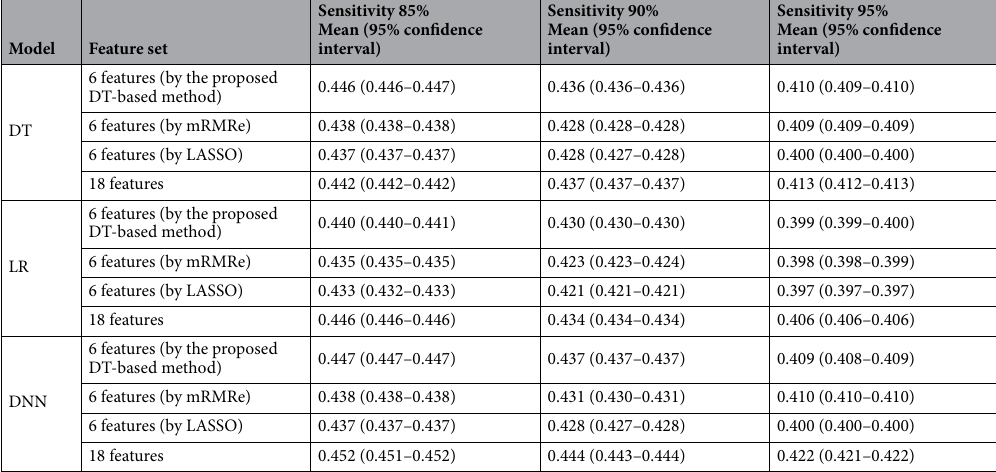
Table 2. The F-1 scores delivered by the alternative prediction models with different feature sets. Please refer to Supplementary Table S6 for the definitions of the F1 score.